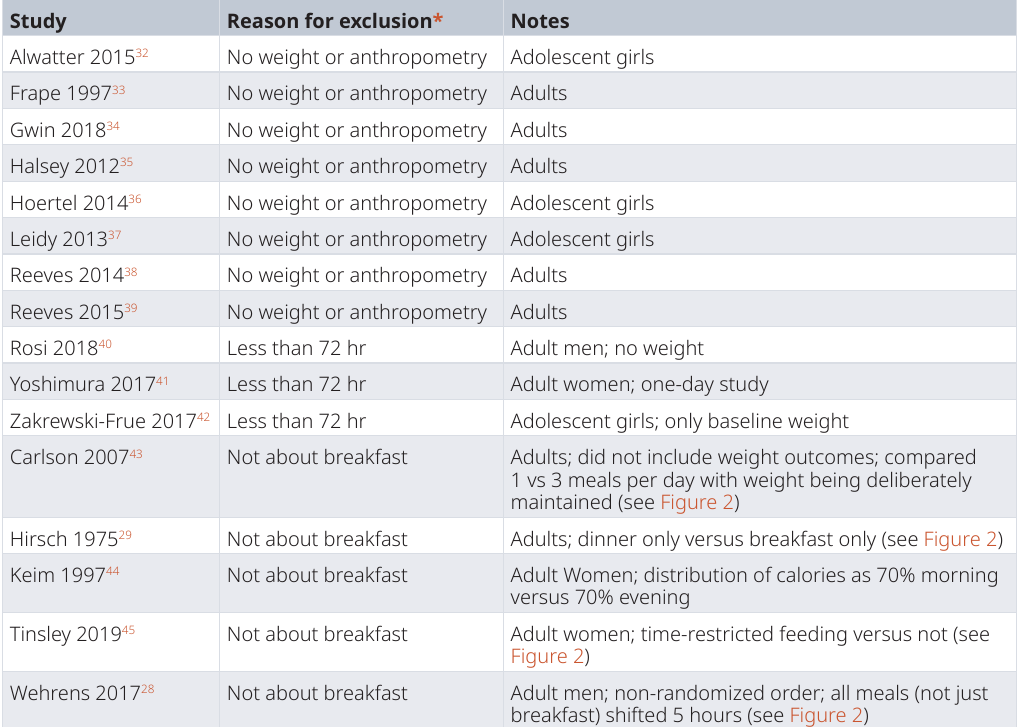
Table 3. Notable studies that were excluded with